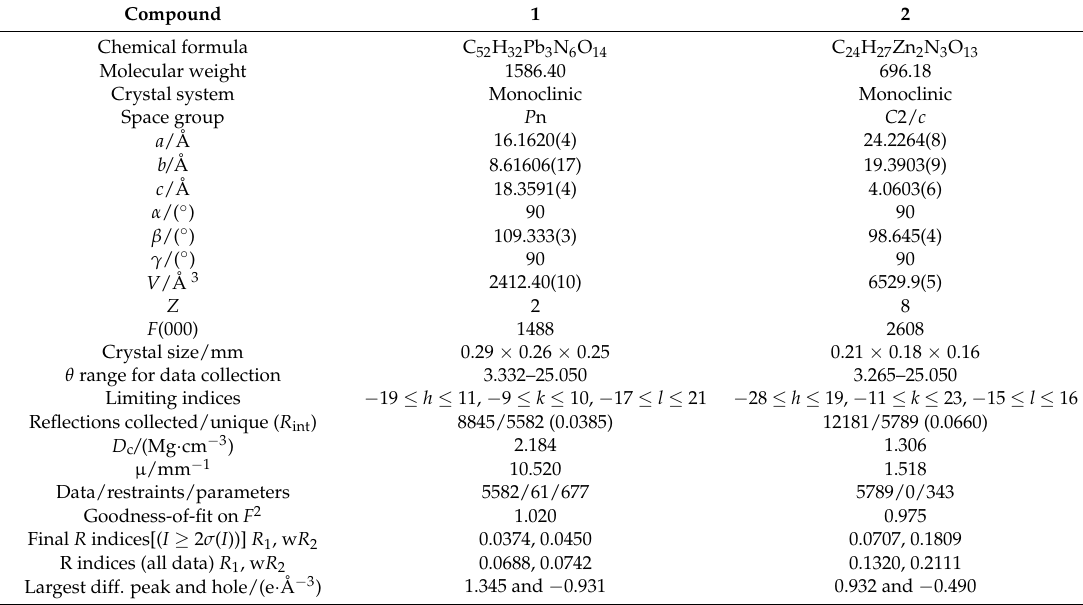
Table 1. Crystal data for compounds 1 and 2